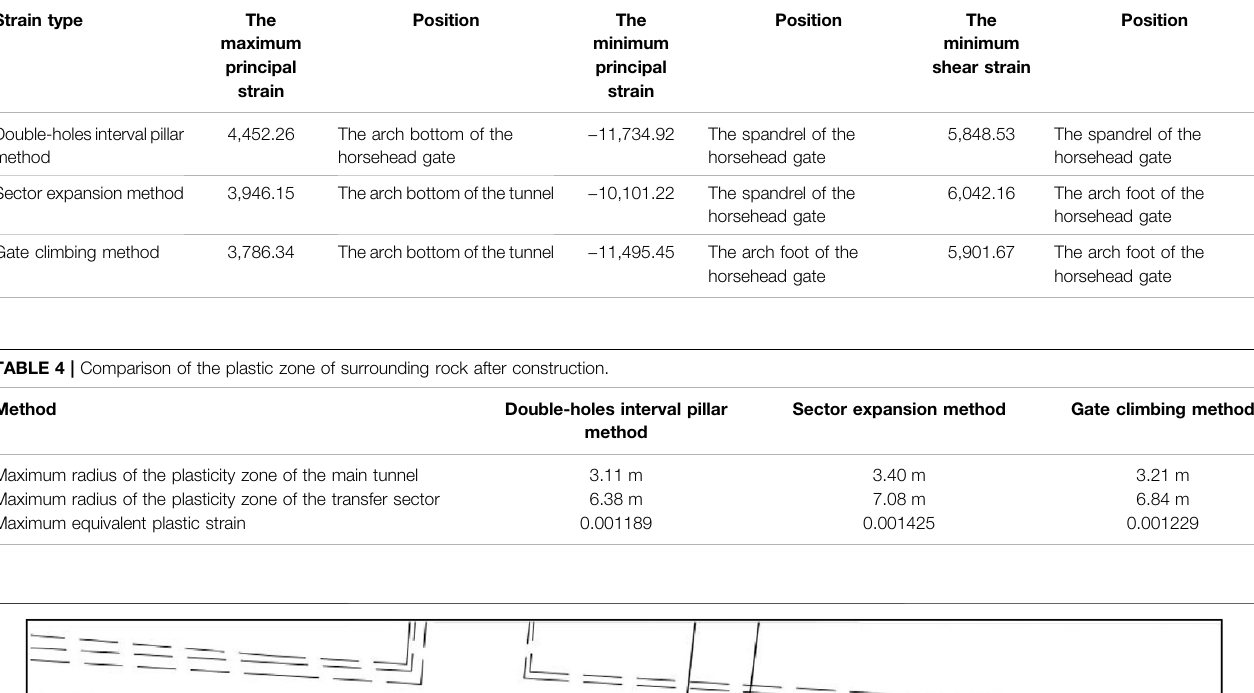
TABLE 3 | Comparison of the strain of the supporting structure (unit: kPa).